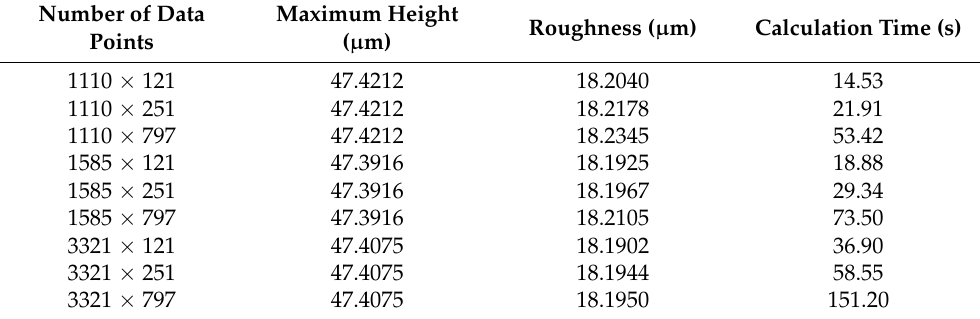
Table 1. Calculation results with different numbers of data points.